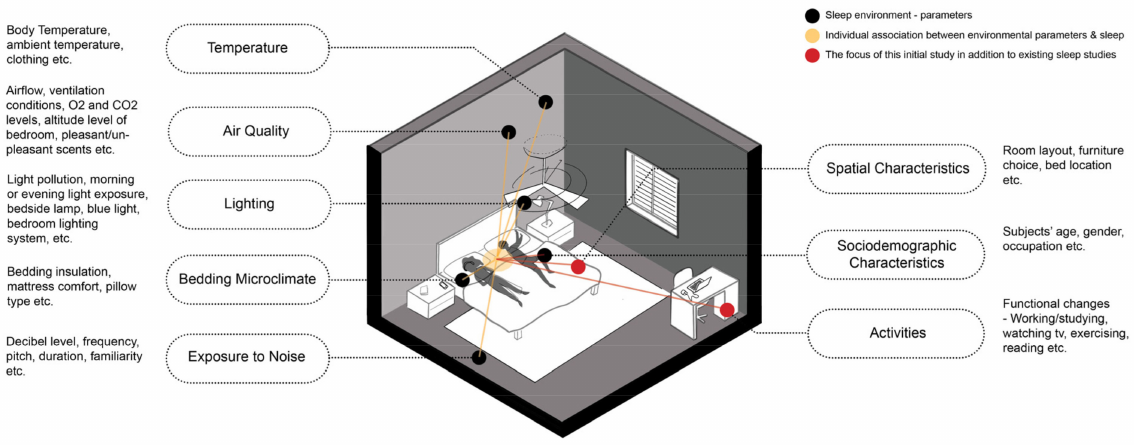
Figure 1. An evaluation of the literature review on sleep environment, illustrated by the